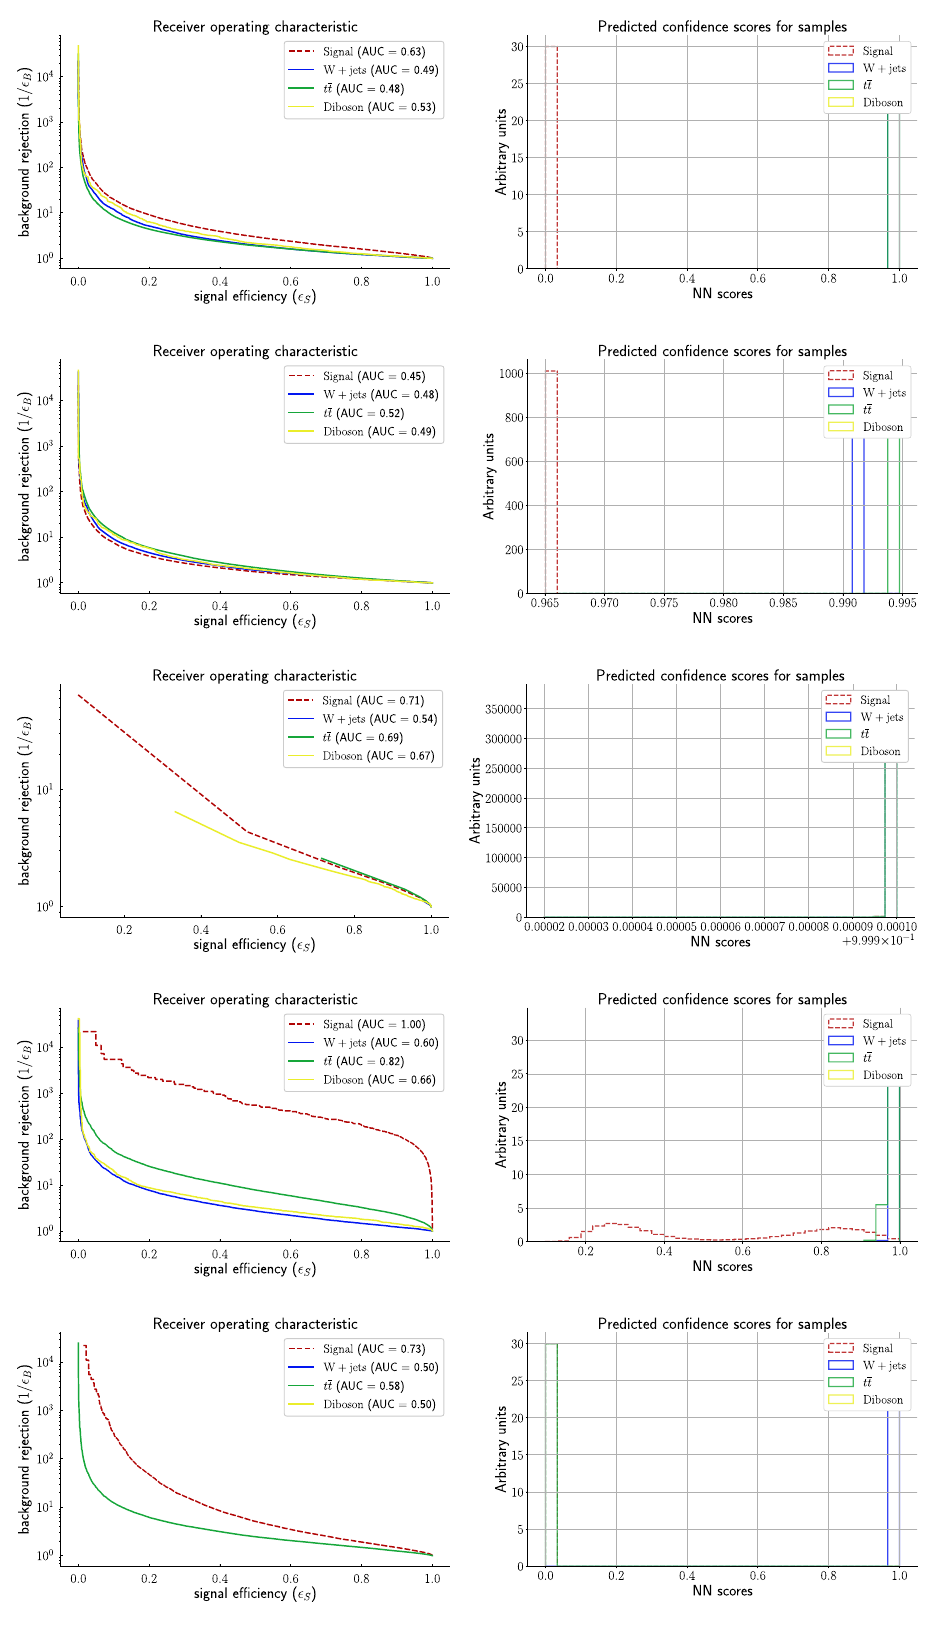
Fig. 13 Receiver operator characteristic (ROC) plots for the neural networks of the doublet VLLs from the masses of 600 GeV (top) to 1000 GeV